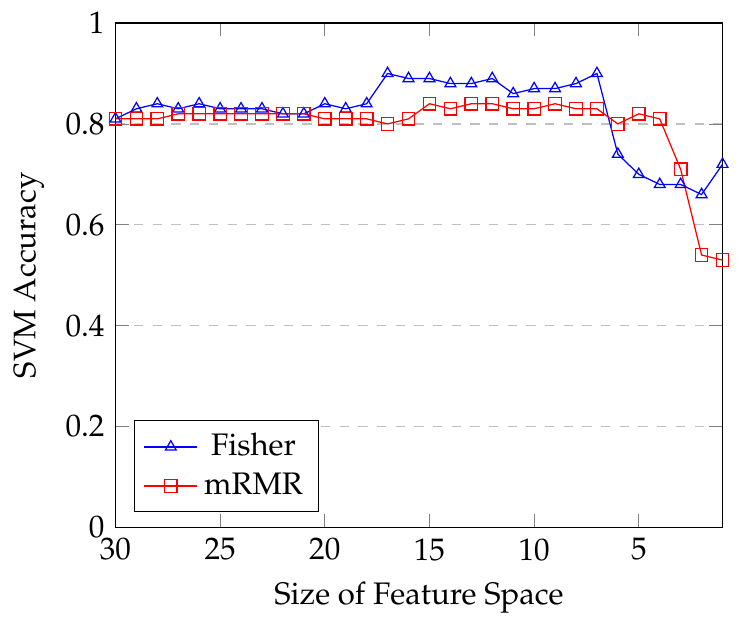
Figure 7. Mean of the accuracy scores from 10-fold cross-validation for SVMs with decreasing number of features. Features order is given by mRmR (see Table 5) and Fisher (see Table 6) algorithms.